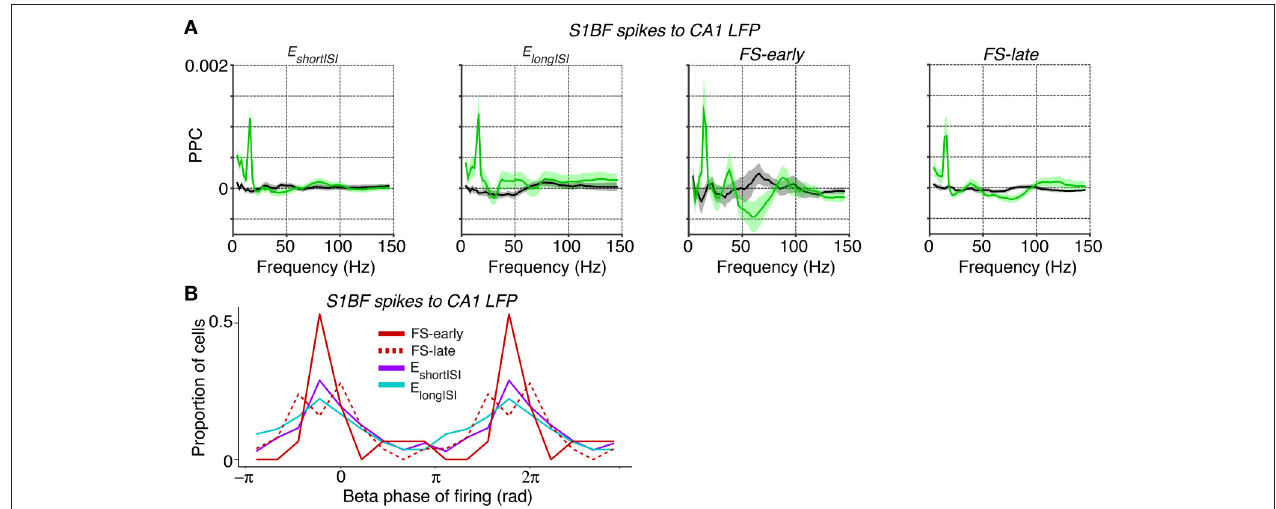
FIGURE 8 | Spike-LFP phase locking between distinct S1BF cells and CA1 LFPs. (A) Entrainment of S1BF E shortISI , E longISI , FS-early and FS-late cells to CA1 LFPs, separately for locomotion and baseline. (B) Population histogram of preferred phases of firing for all FS-early, FS-late, E shortISI and E longISI cells to CA1 beta fluctuations (at 14Hz, the peak in the phase locking spectrum). Y-axis indicates the proportion of cells. The beta cycle is shown twice for visualization purposes. No significant difference was observed in the preferred phases between the four cell classes (Circular ANOVA, p =